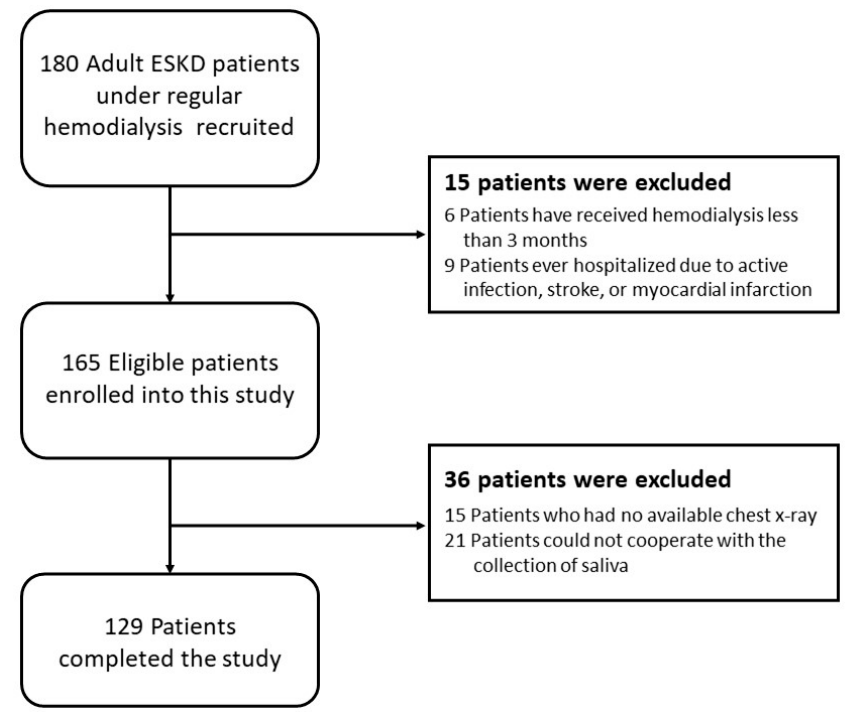
Figure 1. Flow chart of patient enrolment. The diagram shows the enrolment and status of patients. Abbreviations: ESKD, end-stage kidney disease.